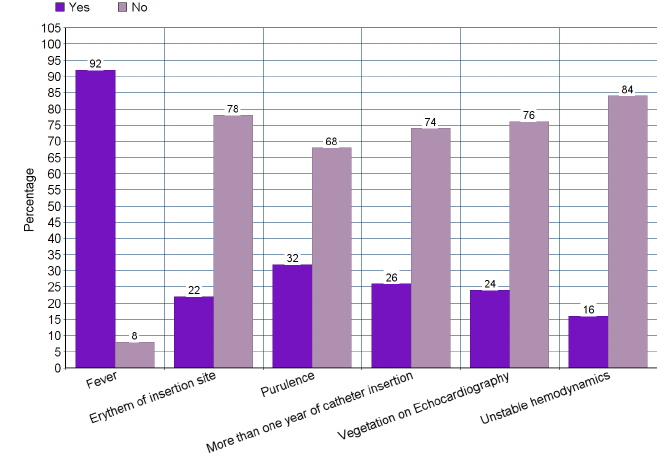
Figure 1. The frequency of systemic clinical signs, as well as infection signs at the site of catheter insertion in hemodialysis patients